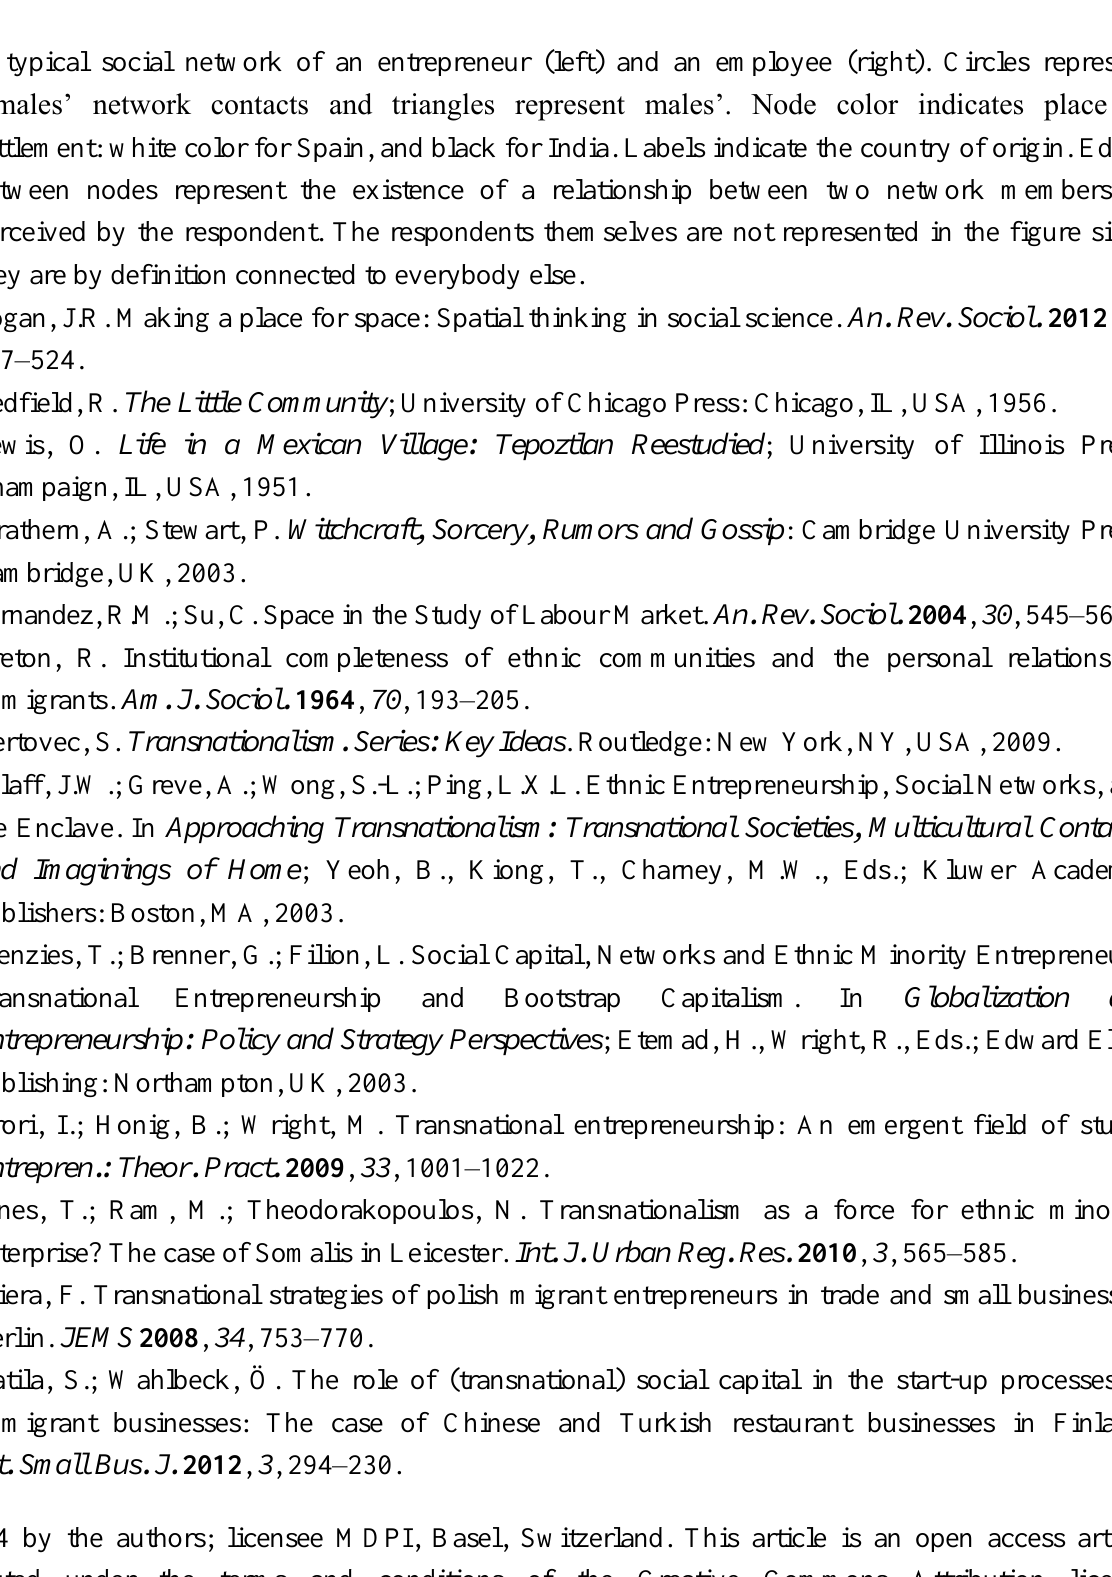
43. A typical social network of an entrepreneur (left) and an employee (right). Circles represent females‘ network contacts and triangles represent males‘. Node color indicates place of settlement: white color for Spain, and black for India. Labels indicate the country of origin. Edges between nodes represent the existence of a relationship between two network members as perceived by the respondent. The respondents themselves are not represented in the figure since they are by definition connected to everybody